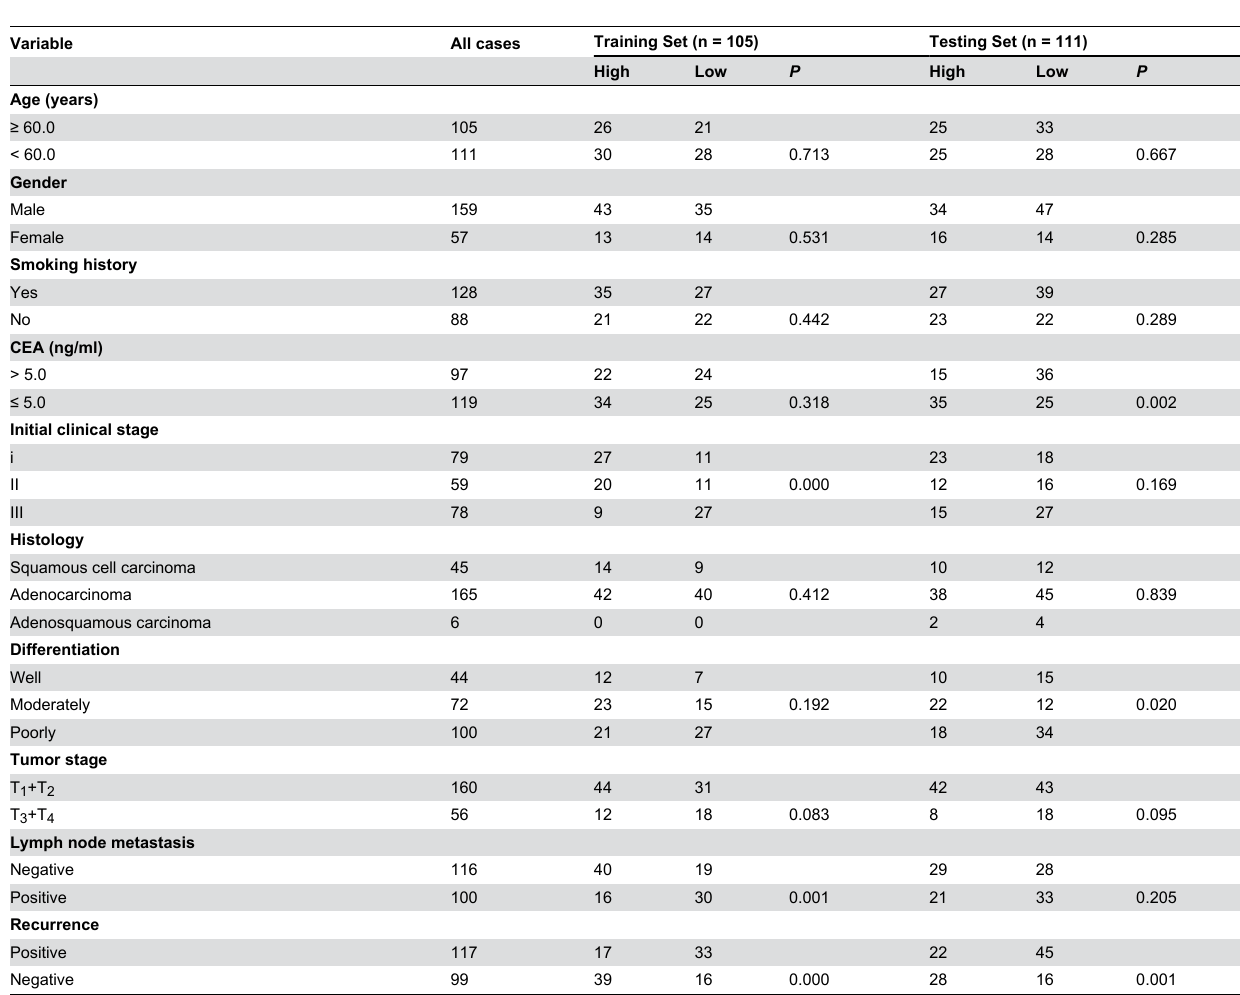
Table 1. Association of Beclin 1 expression with patient’s clinicopathologic characteristics in